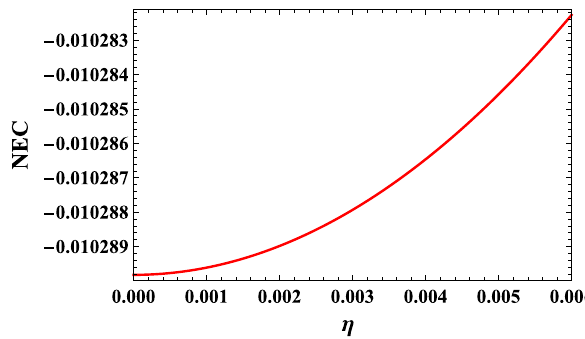
Fig. 7 NEC is shown at the radial distance r = 1 . 5 kpc with respect to the Global Monopole Charge η corresponding to the parameters ρ 0 = 0 . 004 kpc − 2 , α = 0 . 5 , β = 0 . 8 , r th = 1 kpc and r 0 = 2